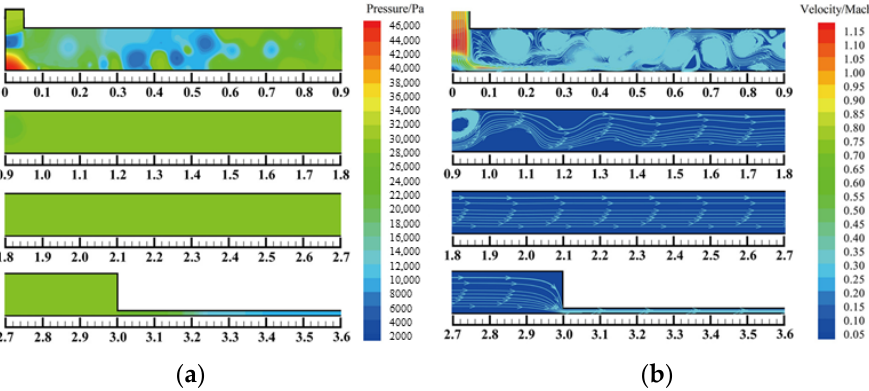
Figure 3. Flow characteristics and fluctuating pressure of ATB ( a ) pressure contours, ( b ) velocity contours [15].